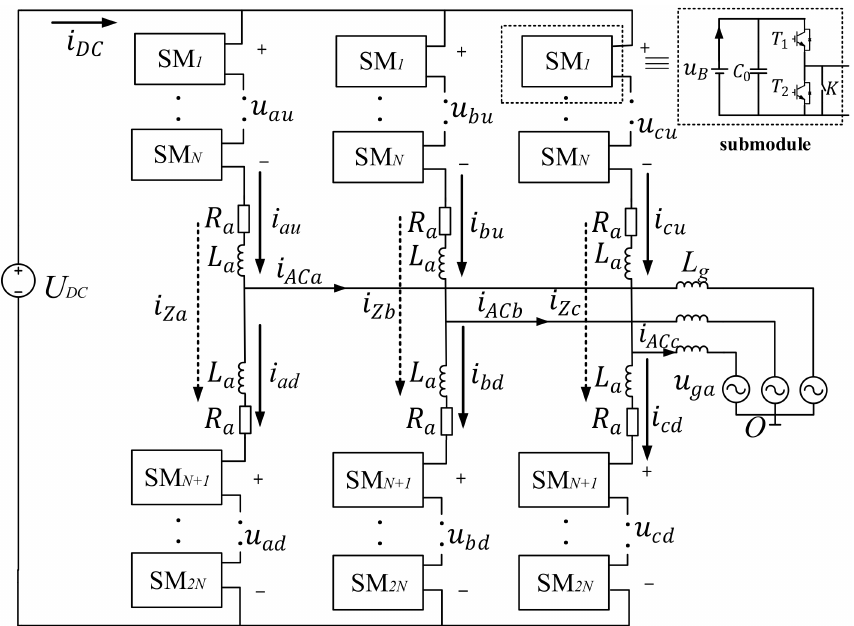
Figure 1. The configuration of the MMC-BESS and its